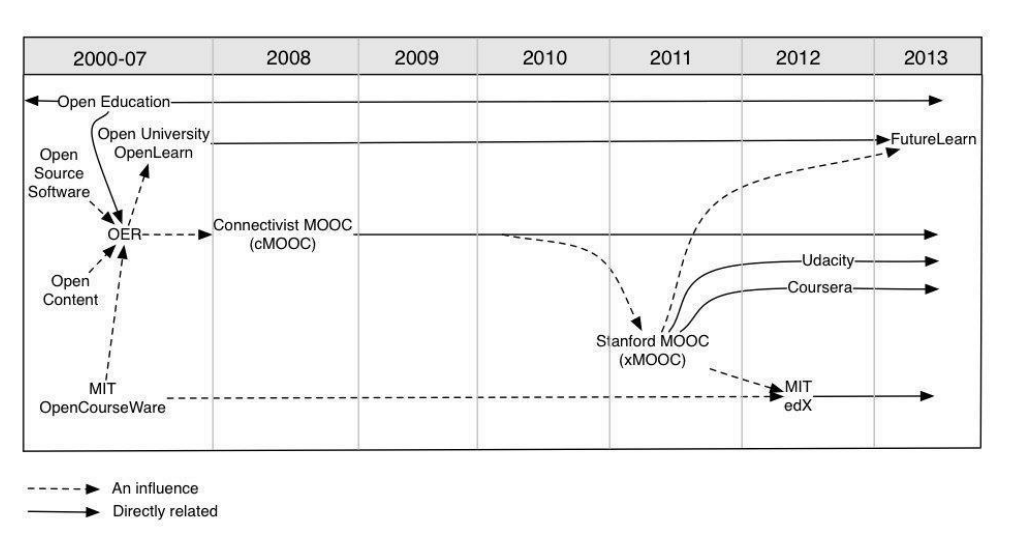
Figure 1. MOOC Timeline (Yuan & Powell, 2013, p.